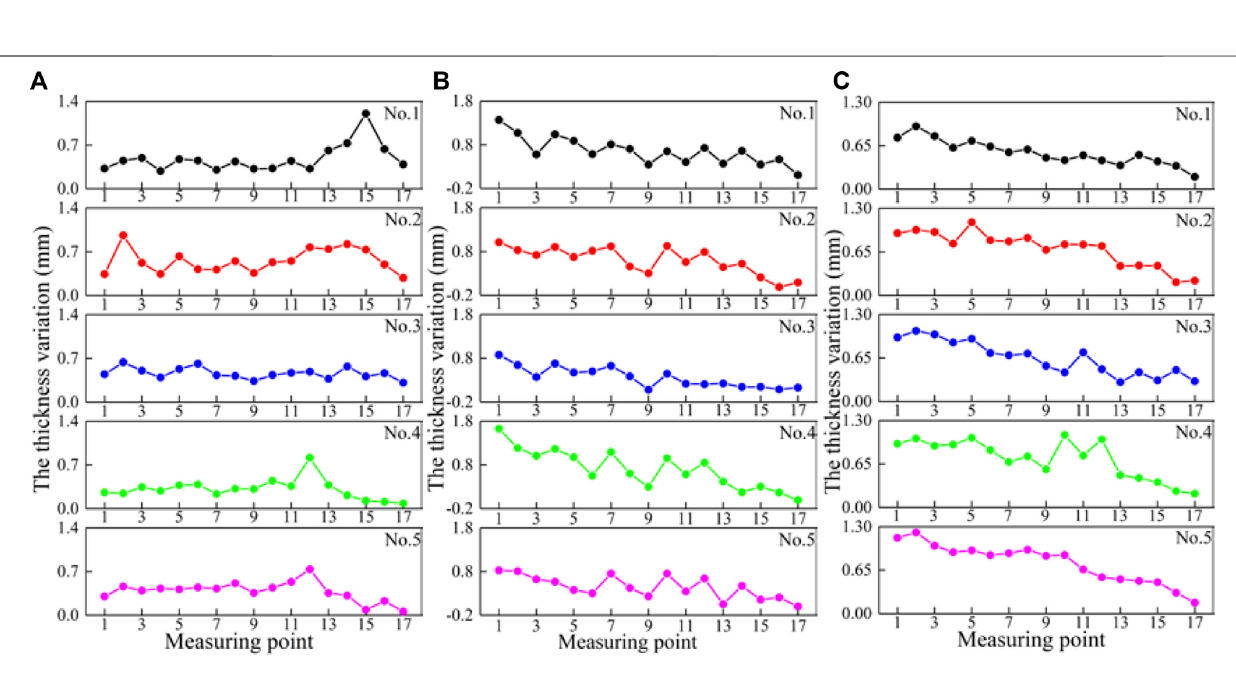
Frontiers in Energy Research |